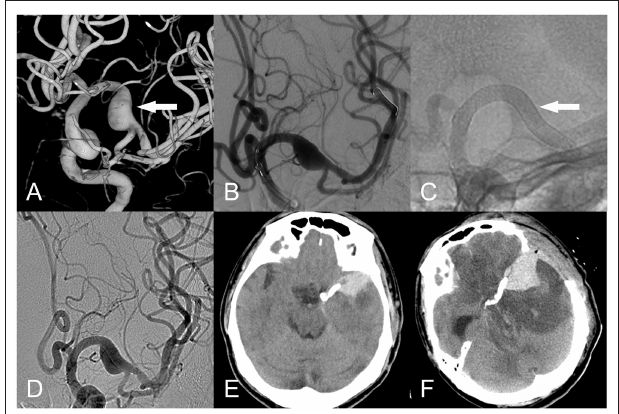
FIGURE 3 | Fusiform aneurysm of the left middle cerebral artery. (A) Three-dimensional reconstruction (white arrow). (B) The PED was implanted intraoperatively uneventfully (white arrow). (C,D) The PED was well adherent, and the contrast was obtained after the release of the PED. (E) Nine hours postoperatively, the patient developed severe headache. CT suggested cerebral hemorrhage with subarachnoid hemorrhage, and decompressive bone flap was performed urgently. (F) 1 day after decompressive surgery by deparaffinization flap, CT suggested significant brain edema around the intracerebral hemorrhage.